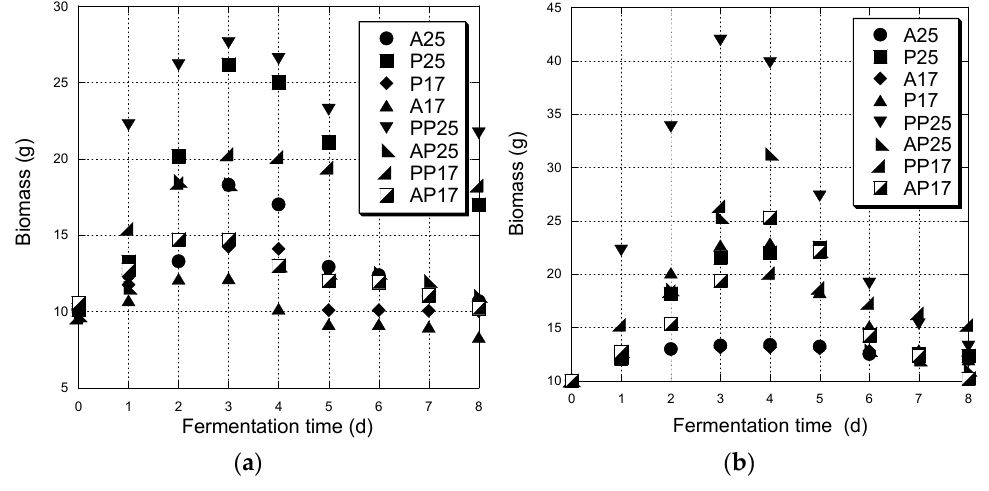
Figure 2. Growth kinetics of water kefir grains ( a ) at 25 °C and ( b ) at 35